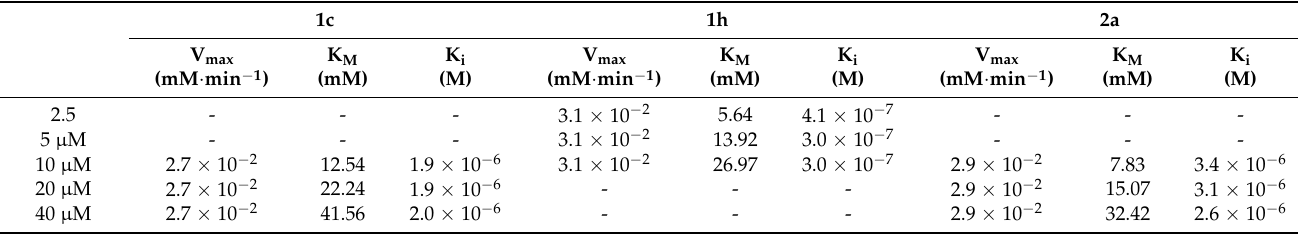
Data were obtained from Lineweaver-Burk plots of mushroom tyrosinase activities. Michaelis Menten constant (K M ), V max , and inhibitor constant (K i ) values were determined at 10, 20, or 40 µ M for 1c and 2a and at 2.5, 5, or 10 µ M for 1h. Data are presented as the mean values of three independent experiments conducted using L-tyrosine concentrations of 1.0, 2.0, 4.0, or 8.0